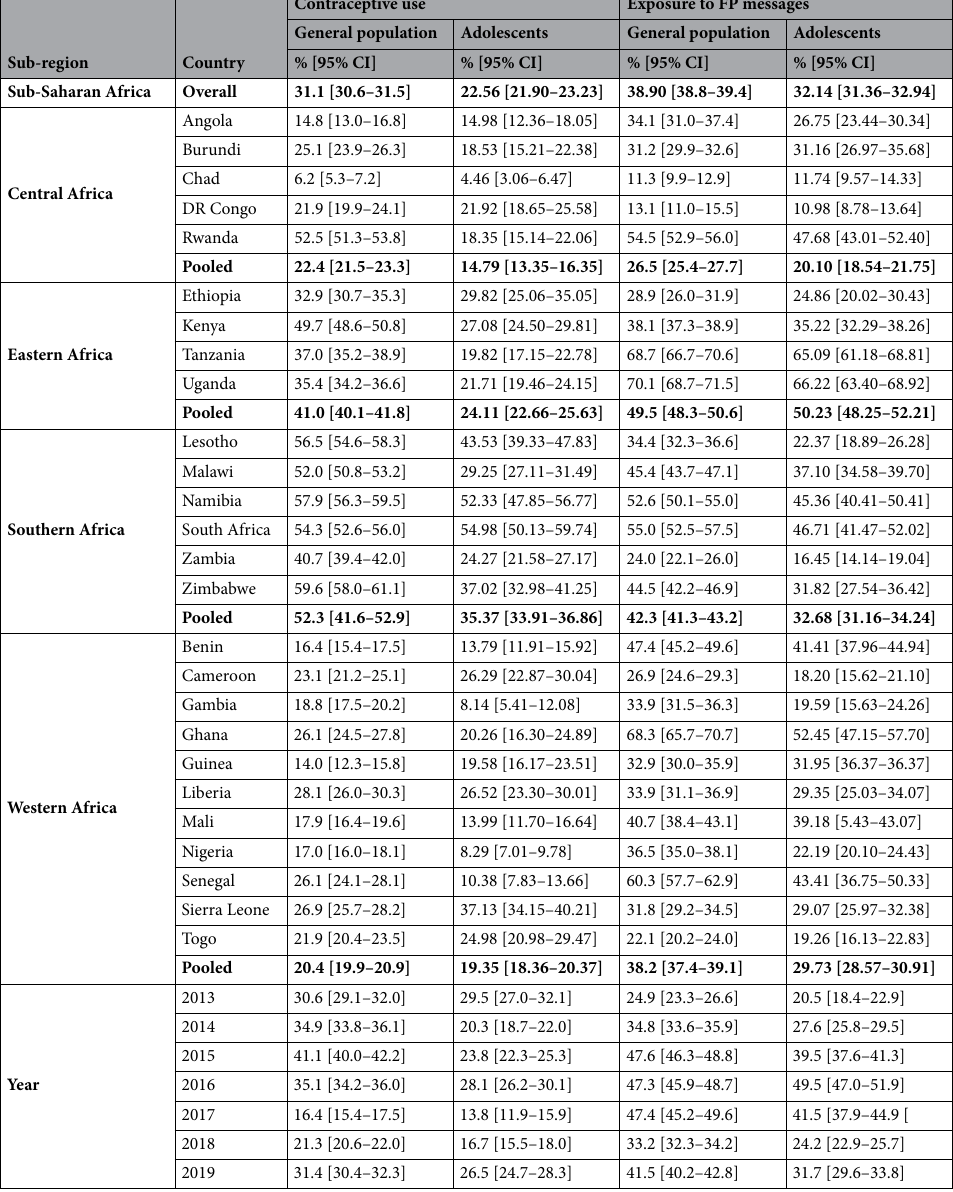
Table 1. Trend of the prevalence of contraceptive use and exposure to family planning among women of reproductive age in sub-Saharan countries (2013–2019). Values in bold highlight the estimates at the regional block